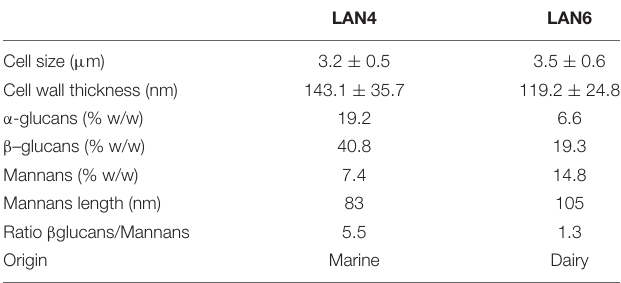
TABLE 2 | Characterization of hydrolyzed D. hansenii -based products.